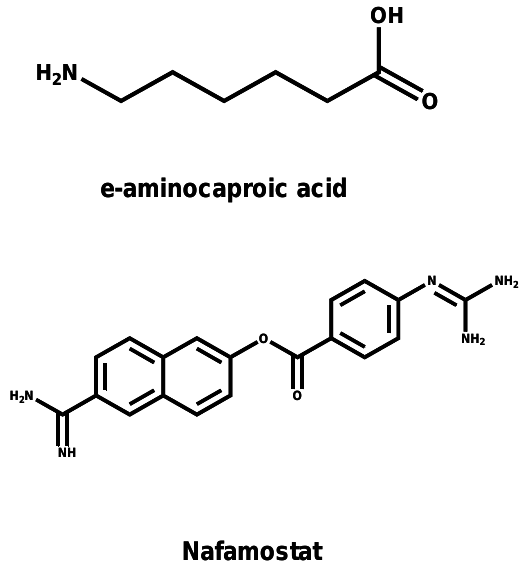
Figure 5. The chemical structures of IAV inhibitors by suppressing the cleavage of the HA precursor HA0 into the functional HA1 and HA2